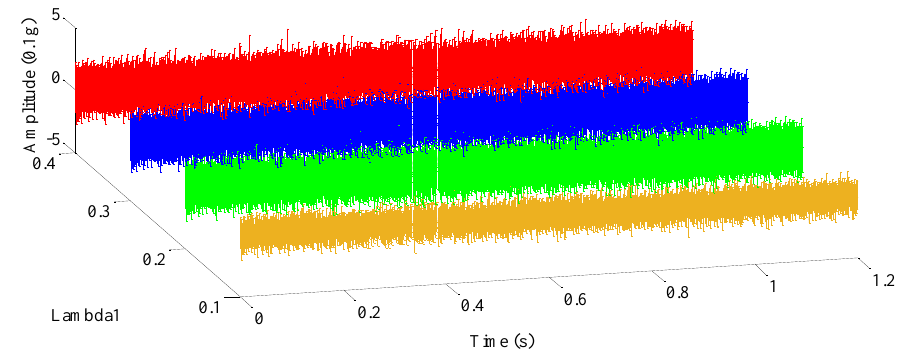
Figure 11. Low-resonance components in cases where λ 1 =